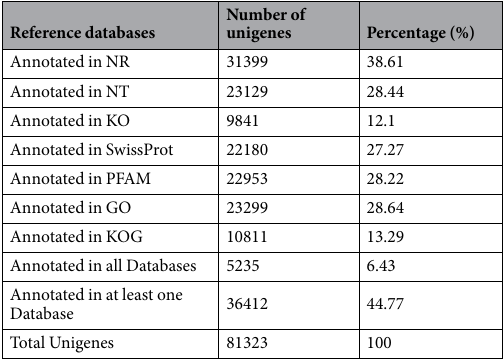
Reference databases